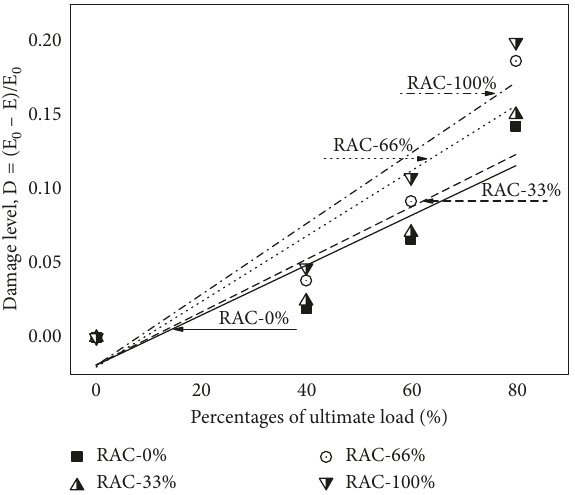
Figure 9: Imposed load damage of RAC with various percentages of ultimate compressive